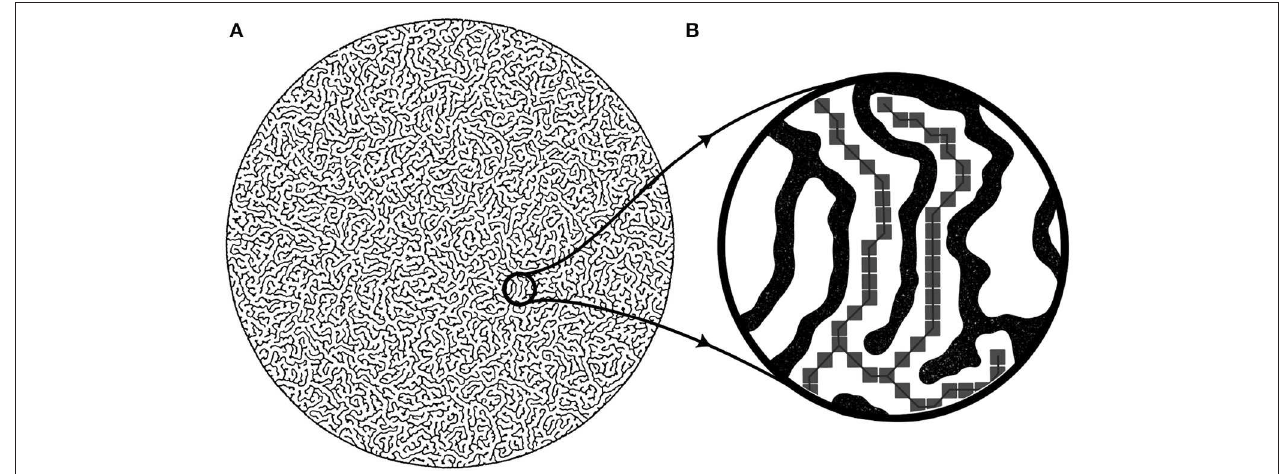
FIGURE 1 | Figure showing a frictional finger pattern (A) together with the one-dimensional skeletonized tree-structure obtained by contracting the finger widths to zero (B) . The skeletonized pattern is pixelized before random walkers are released as discussed in section